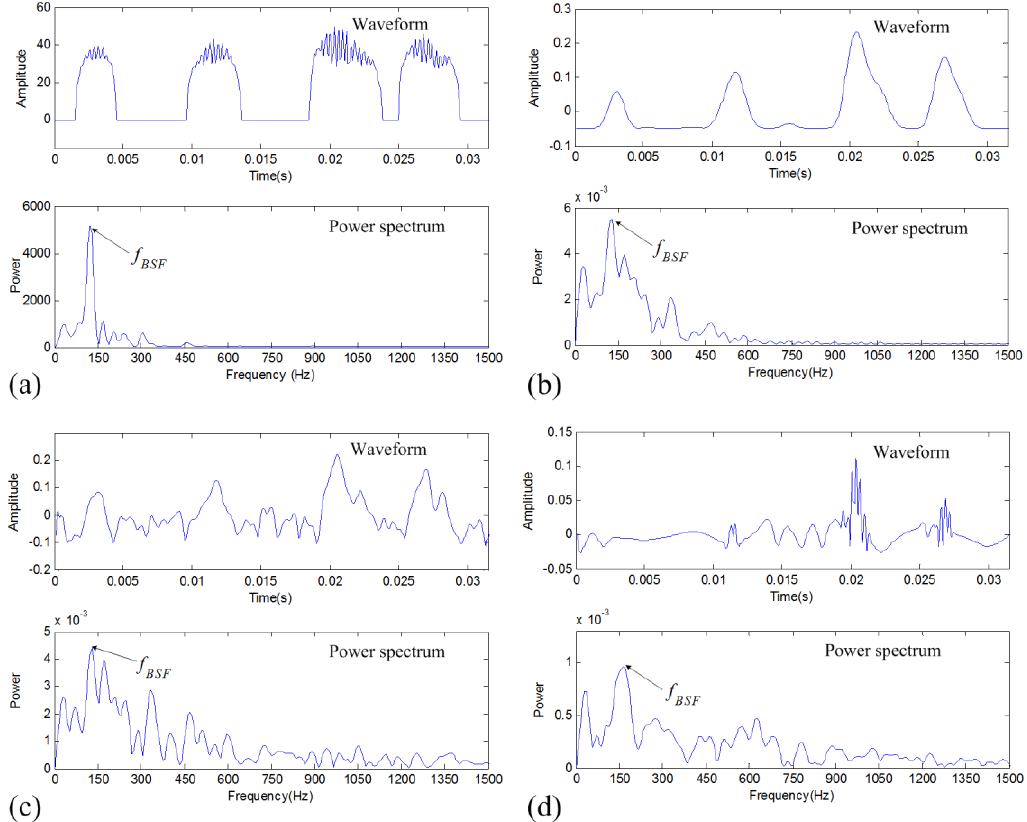
Figure 8. Fault diagnosis results of rolling-element defective vibration signal: ( a ) FPTS spectrum of TFM-based denoised signal; ( b ) envelope spectrum of TFM-based denoised signal; ( c ) envelope spectrum of band-pass filtered signal; and ( d ) envelope spectrum of DWT-based denoised